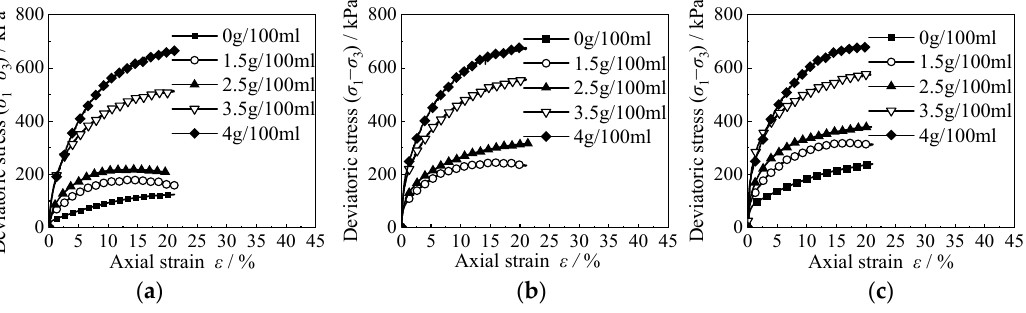
Figure 8. The stress–strain curves when using different cement contents. ( a ) C = 3.5 g/100ml, σ′ m = 50 kPa, ( b ) C = 3.5 g/100ml, σ ' m = 100 kPa, ( c ) C = 3.5 g/100ml, σ′ m = 150kPa.